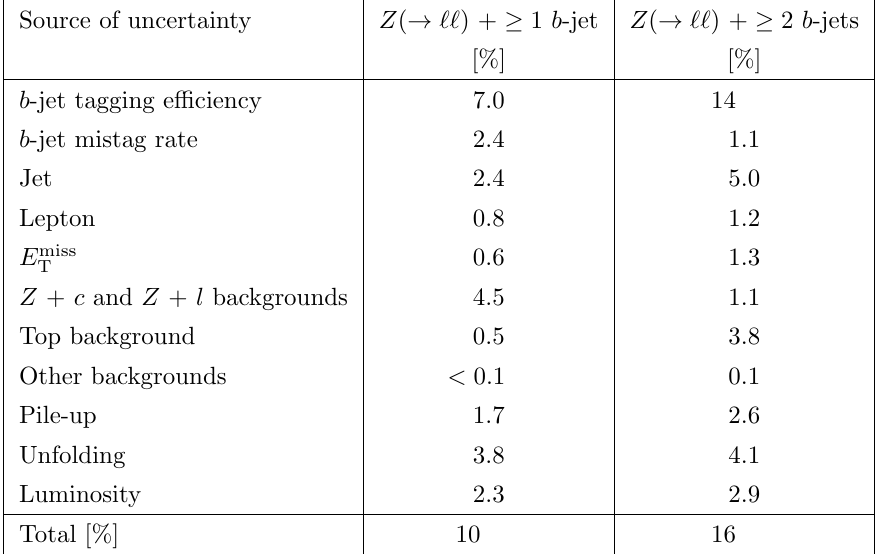
Table 8 . Relative systematic uncertainties in the measured production cross-sections of Z ( ! ‘‘ ) + (cid:21) 1 b -jet and Z ( ! ‘‘ ) + (cid:21) 2 b -jets events. The \Jet" term includes the JES, JER and JVT uncertainties. The \Lepton" term includes the lepton trigger, e(cid:14)ciency, scale and resolution uncertainties. The \ Z + c and Z + l backgrounds" term also includes the Z + 1 b background in the Z + (cid:21) 2 b -jets